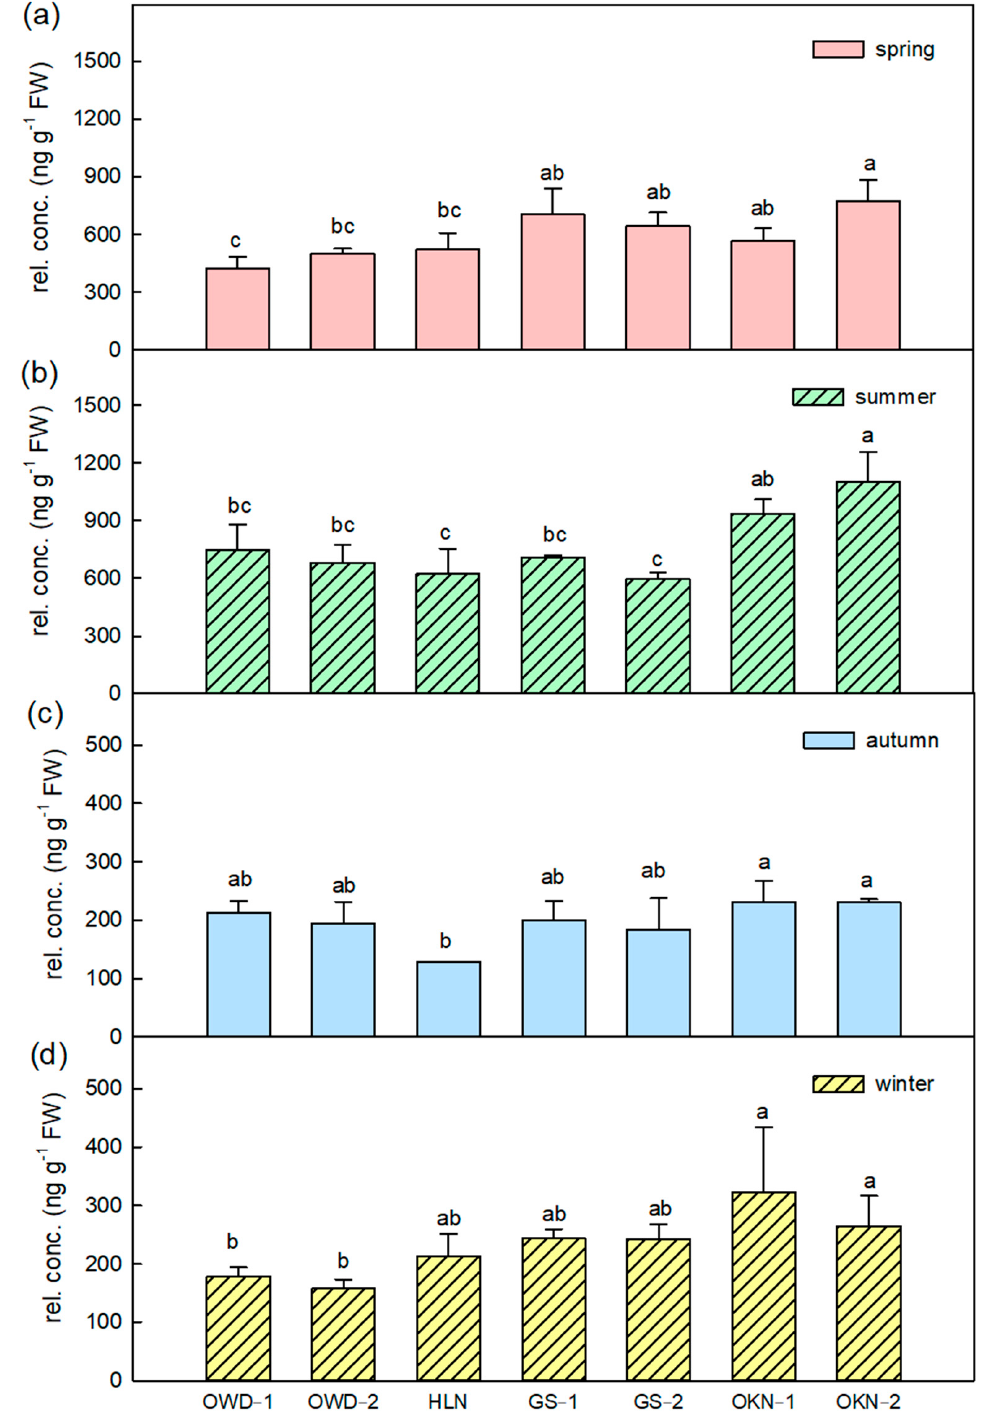
Figure 3. The γ -terpinene variations in Citrus depressa fresh leaf among all accessions in each season, which is ( a ) spring; ( b ) summer; ( c ) autumn; and ( d ) winter. Each bar showed the average ( n = 3) of the relative concentration (rel. conc.) The error bar was calculated by standard errors, and the different letters showed a significant difference (LSD p < 0.05). The VOCs β -ocimene and limonene are important compounds of the fresh leaf aroma, and the average content ratios of the two VOCs are 2.4% and 1.8%, respectively. They contribute the fresh, herbal and citrus scents in citrus leaves. Fresh leaves of C. de-